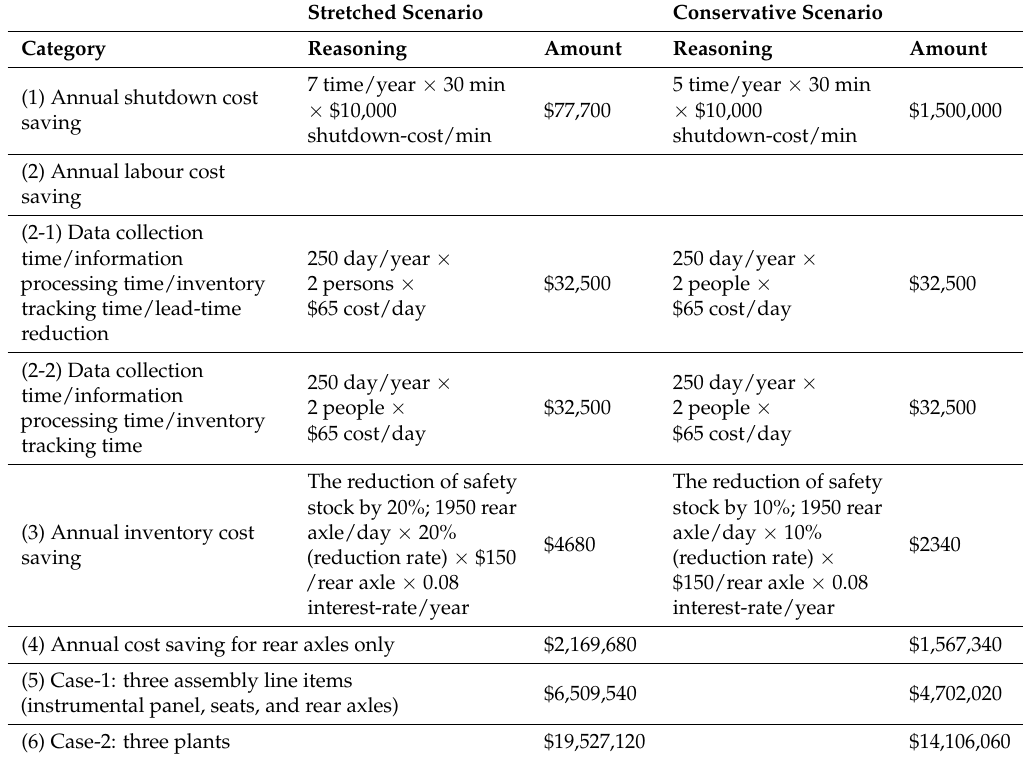
Table 3. Comprehensive shutdown cost estimation (unit $: